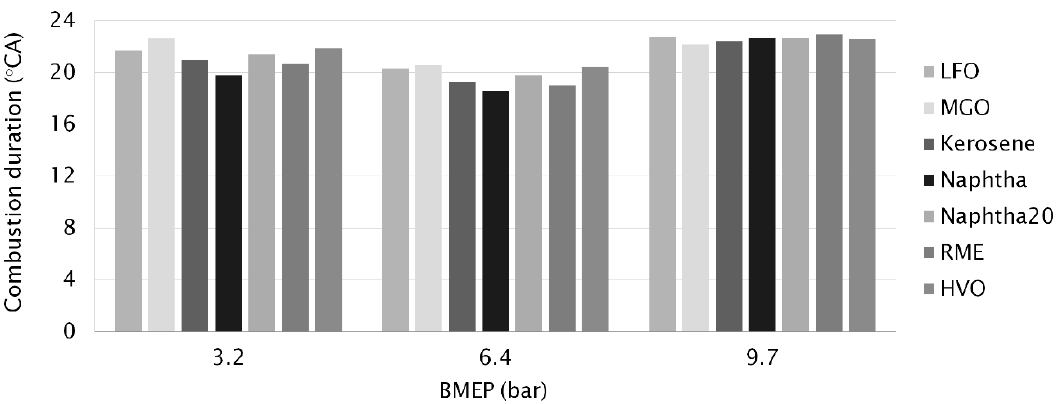
Figure 4. Combustion duration (°CA) at different engine-loads, determined as crank angles between MFB 5% and MFB 90%.